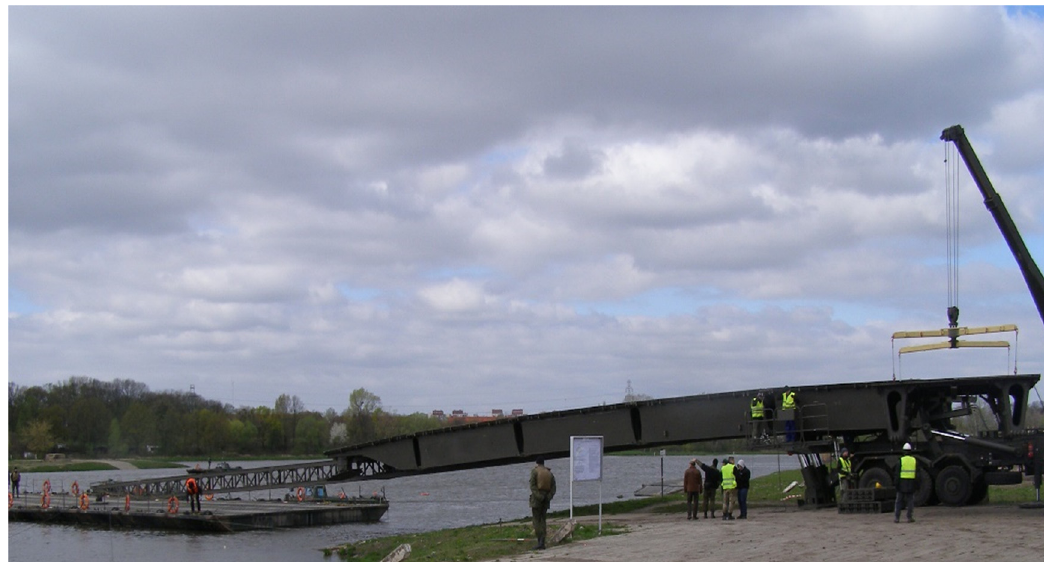
Figure 3: MS - 40 bridge being placed on a fl oating support.